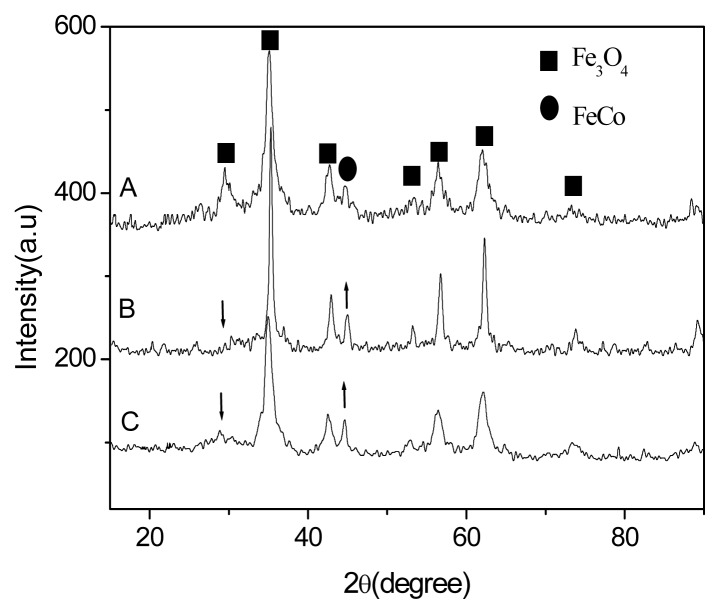
XRD pattern of FeCo-Fe3O4 composite particles prepared at various temperatures (A) 130 °C; (B) 150 °C; and (C) 170 °C.